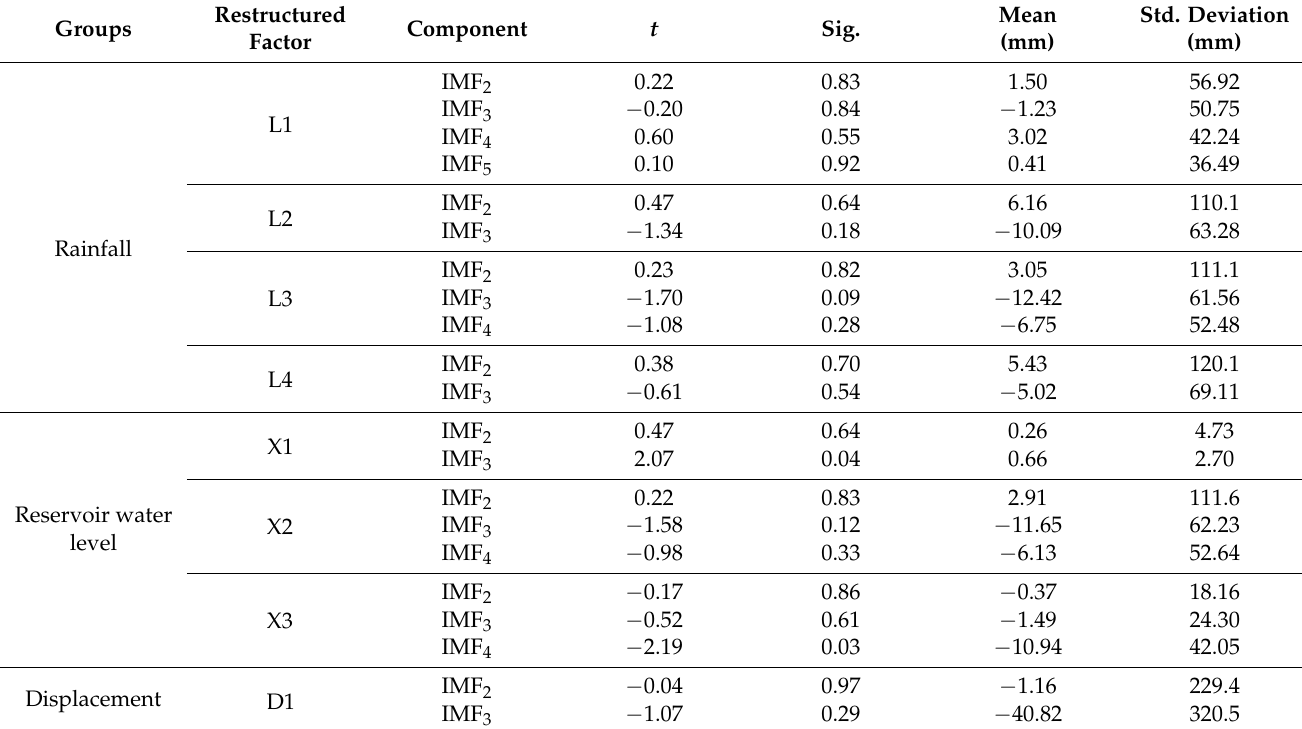
Figure 11. IMFs of restructured factors derived through CEEMD. Table 1. Paired t -test results of all decomposed IMF.